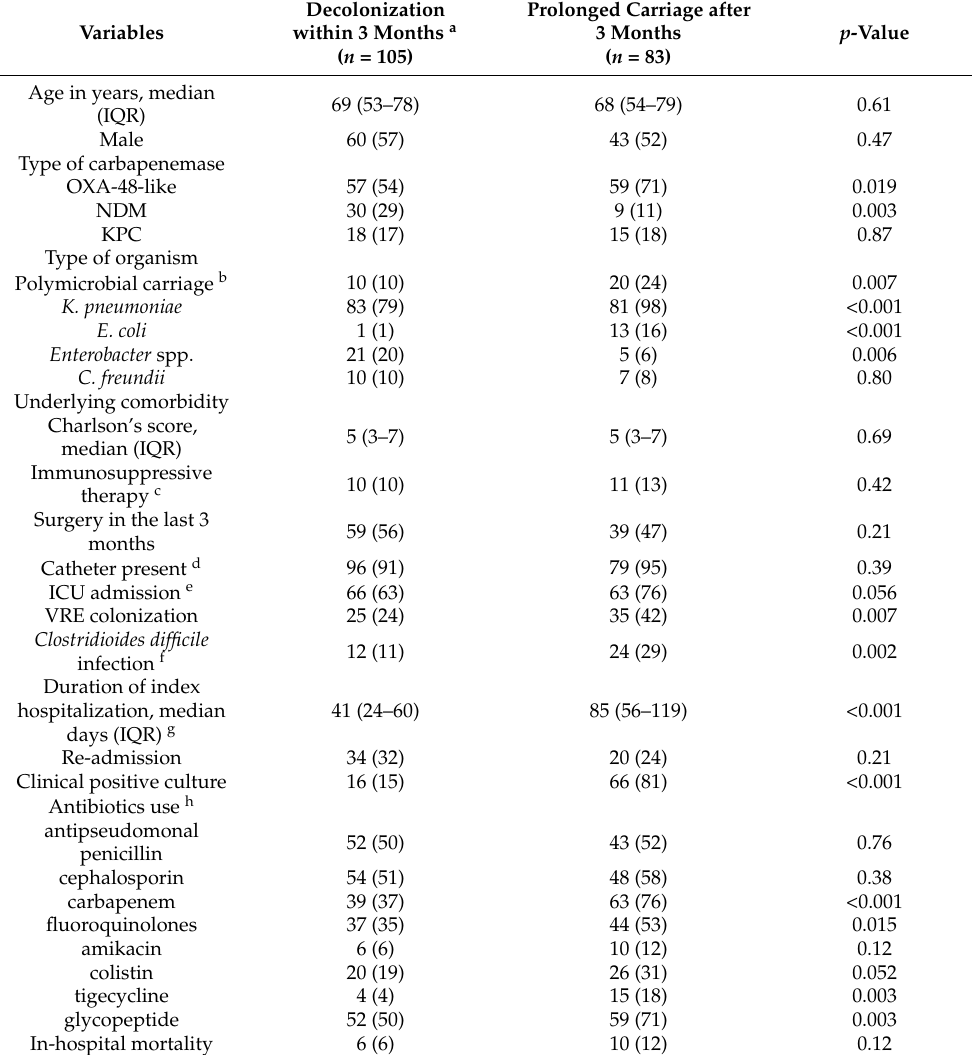
Table 1. Clinical characteristics of patients with carriage of carbapenemase-producing CRE who experienced spontaneous decolonization within 3 months or prolonged carriage after 3